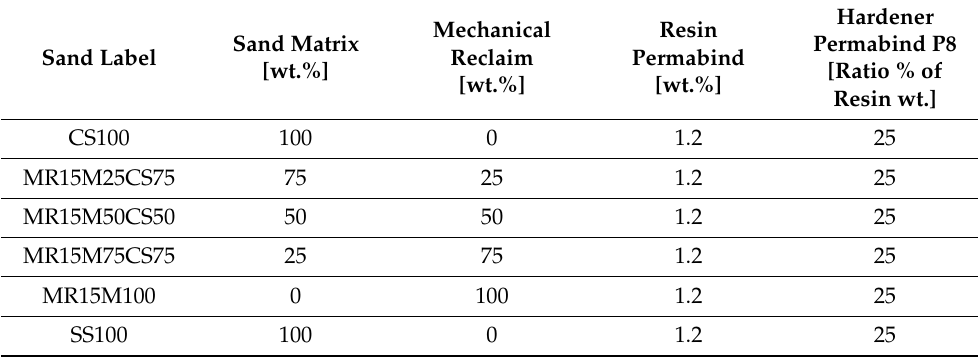
Table 1. Moulding sand mixtures for alkali-phenolic process.